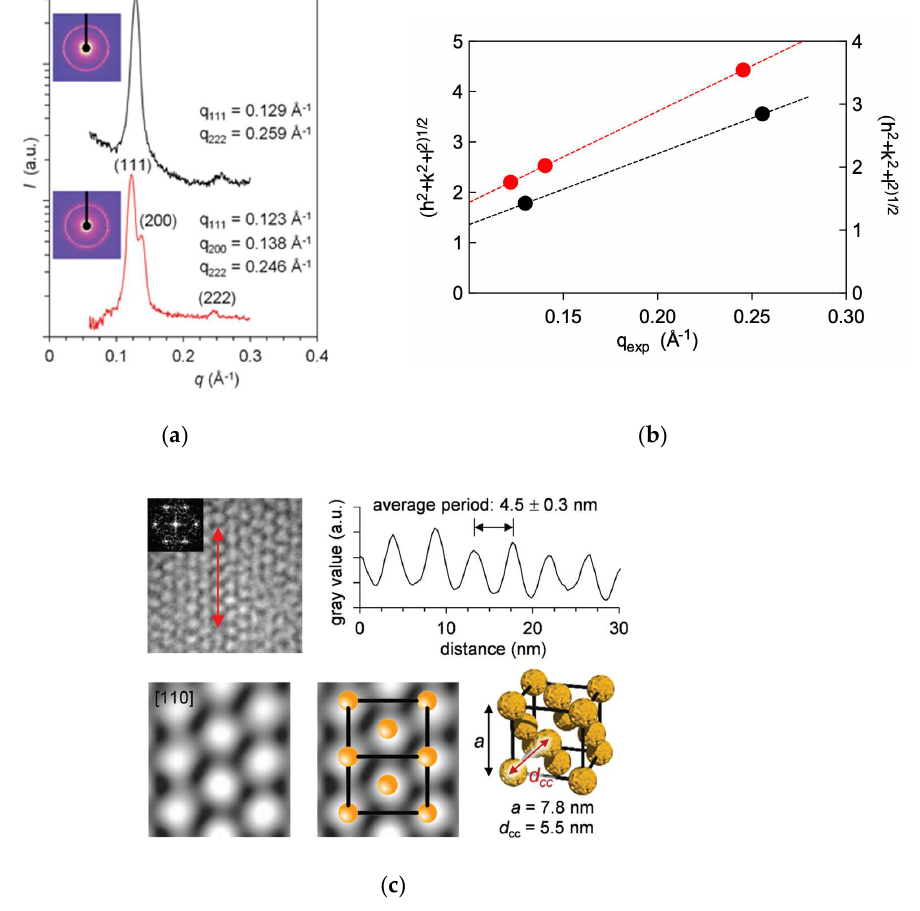
Figure 9. ( a ) Integrated SAXS curve measured from self-assembled dendrimers C 14 G 0 (black upper curve) and C 16 G 0 (red lower curve) in the presence of heparin. The insets show the corresponding 2D diffraction patterns. ( b ) Quadratic Miller indices of assigned reflections for face-center cubic ( fcc ) structures as function of measured q -vector positions for indexed peaks, related with heparin-bound C 14 G 0 (black symbols) and C 16 -G 0 micelles (red symbols). ( c ) (Top row) A crystalline area for C 14 G 0 (top left; inset: Fast Fourier transform) and a line profile analysis (top right) along the red double pointed arrow shown in the top left panel. (Bottom row) Filtered inverse Fourier transform from selected Fourier components for the C 14 G 0 (left), overlay of the image and the fcc unit cell (center), and model of the unit cell with key dimensions (right). The micelles are shown in yellow using a reduced D m value for clarity. Adapted from [26] with the permission of The Royal Society of Chemistry.